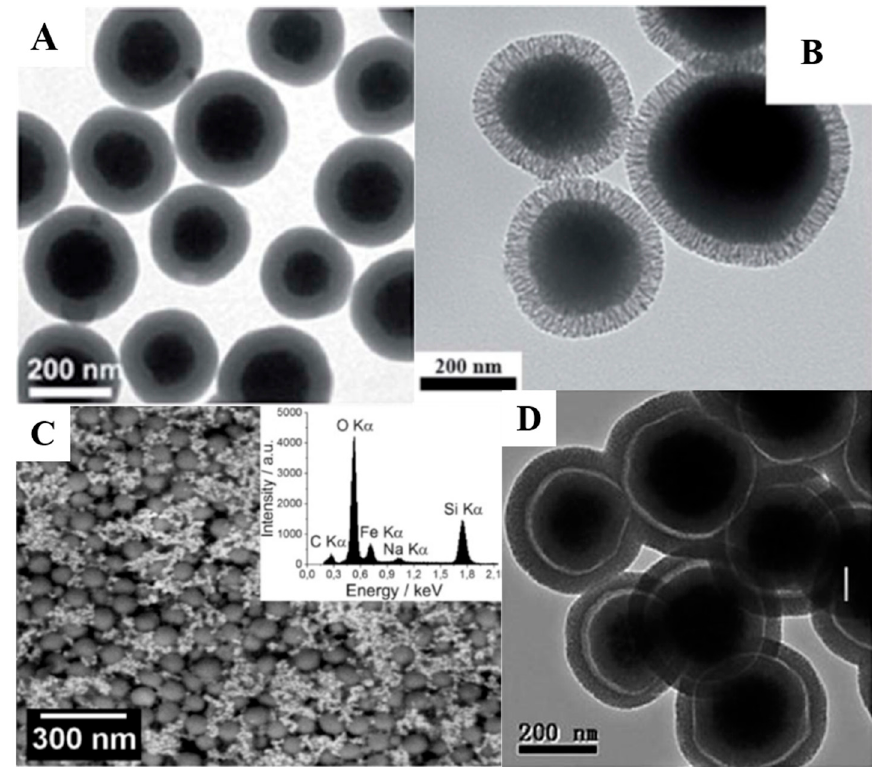
Figure 1. ( A ) TEM image of non-porous silica covering Fe 3 O 4 nanoparticles (reproduced with permission from [36], published by Royal Society of Chemistry, 2015; ( B ) TEM image of mesoporous-silica covering Fe 3 O 4 nanoparticles (reproduced from [37], published by Royal Society of Chemistry, 2018); ( C ) SEM images of Raspberry-like” supraparticle system (reproduced with permission from [38], published by ChemNanoMat, 2019); and ( D ) TEM micrographs of Fe 3 O 4 @SiO 2 @h-mSiO 2 (reproduced with permission from [36], published by Royal Society of Chemistry, 2015).